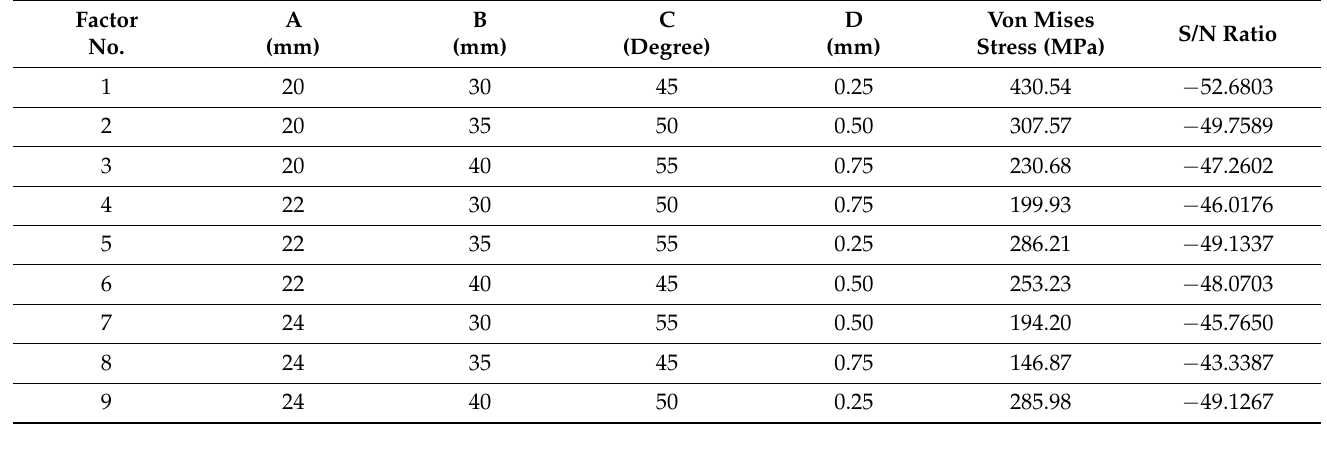
Table 2. Design parameters values per L9 orthogonal array.